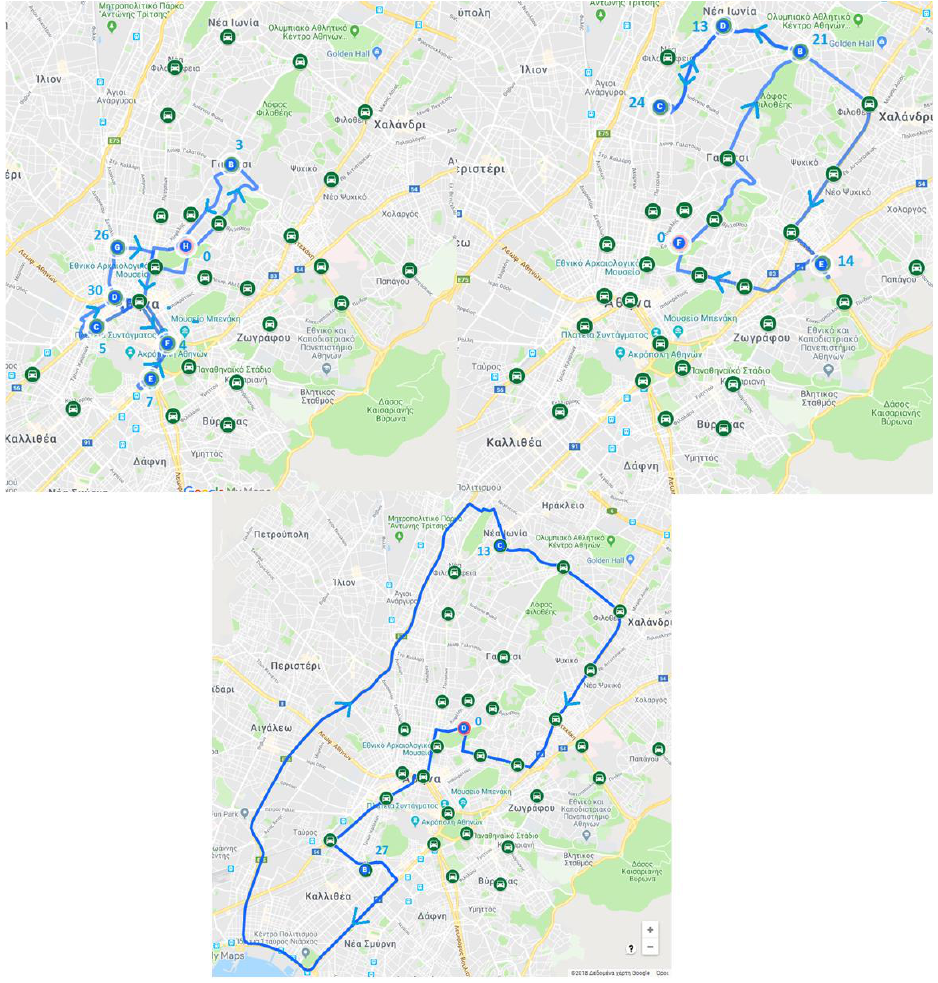
Figure 5. Routes for vehicles 9 ( top left ), 10 ( top right ), 11 ( bottom ).